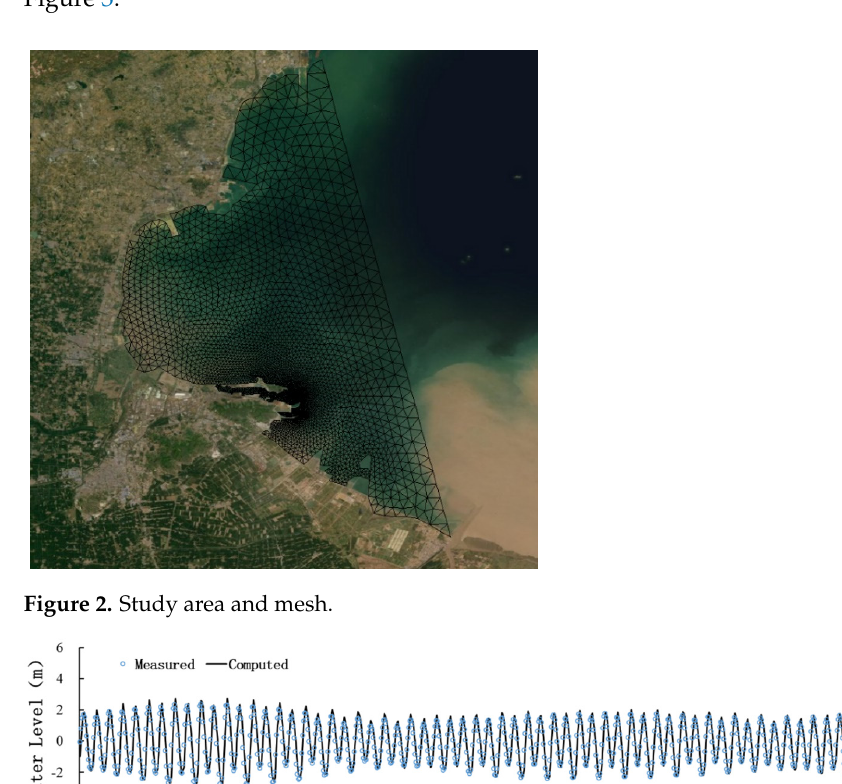
Figure 2. Study area and mesh.